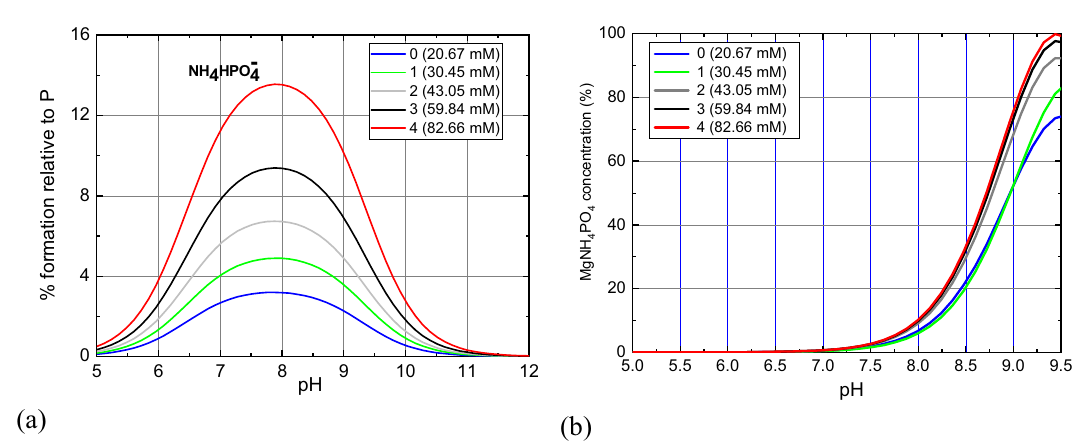
Figure 8. Percentage content of different complexes ( a ) NH 4 HPO 4− and ( b ) MgNH 4 PO 4 , formed with NH 4+ ions versus pH of artificial urine for different P concentrations given in the